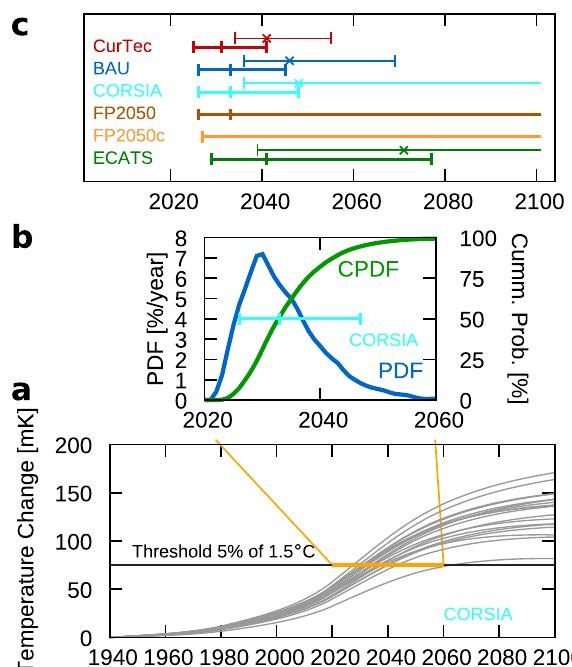
Fig. 4 Analysis of year and likelihood that aviation surpasses a climate target. a Potential pathways ( fi rst 20 realisations of the Monte – Carlo simulation) for the CORSIA Scenario (grey). 5% of the 1.5°C ( = 75mK) is indicated as a black line. Crossings of the brown line with the grey line indicate the year when the threshold is surpassed. b Probability density function (PDF, blue) and cumulative probability density function (CPDF, green) for the year in which the climate target of 5% of 1.5°C is surpassed (and stays above). The horizontal bar indicates the 95%, 50% and 5% percentiles. c 95%, 50% and 5% percentiles of the year in which the climate target is surpassed for 5% of 2 °C (thin top lines with crosses) and 5% of 1.5°C (thick bottom lines). For both FP2050 scenarios, the 5% of 2 °C target is not surpassed in >95% of the cases, hence there is no thin line, and for FP2050 scenario with continuous improvements (FP2050-cont) the 50% percentile is beyond 2100. The scenarios describe a future use of current technology, i.e. without technology improvements (CurTec), a business-as-usual future technological improvement (BAU), the offsetting scheme of the international civil aviation organisation (CORSIA), and 2 Flightpath 2050 scenarios which differ in the speed of technology improvements (FP2050 and FP2050-cont) and bottom-up estimates based on a group of experts from ECATS (Environmentally Compatible Air Transportation